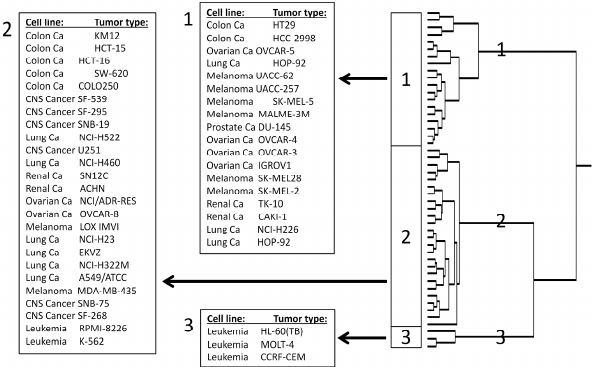
Figure 6. Cluster image mapping of mRNA expression of genes obtained by COMPARE analyses obtained for scopoletin. The gene expression has been determined by using the Novartis microarray platform. The dendrograms show the clustering of the NCI cell line panel according to the degrees of relatedness between cell lines. The cluster image map is based calculations with the WARD method.